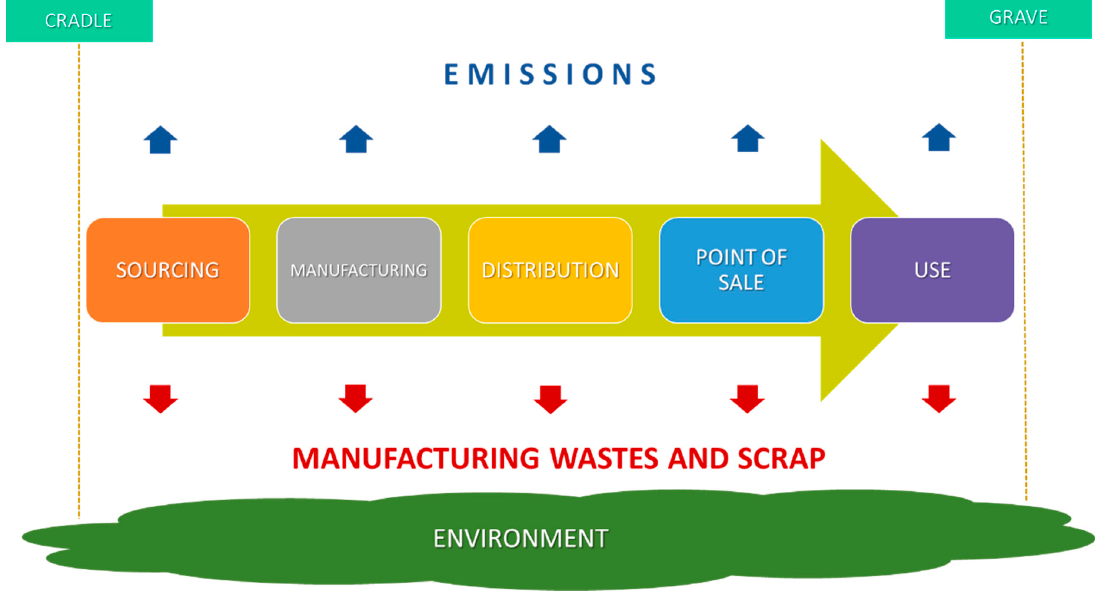
Figure 2. Diagram of a general manufacturing process.